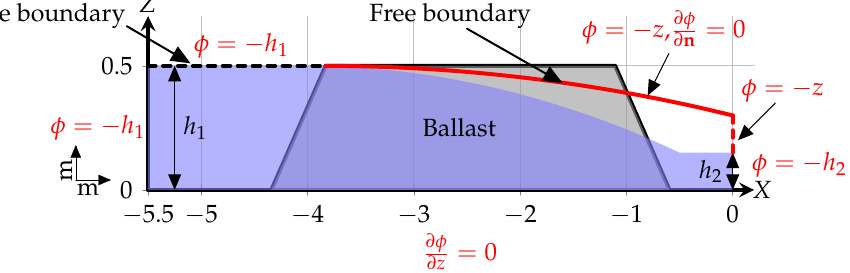
Figure 5. Schematic diagram of the Tsubaki’s experiment and the boundaries conditions of the hydraulic head φ for this study, where h 2 is assumed to be 0.001.